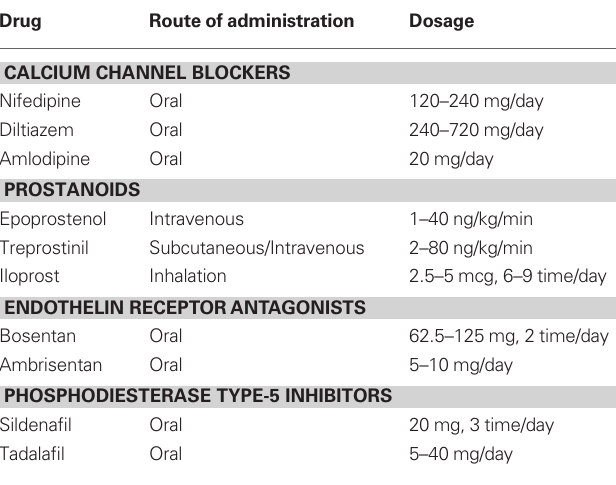
Table 4 | Main pharmacological characteristics of the drugs used in the specific